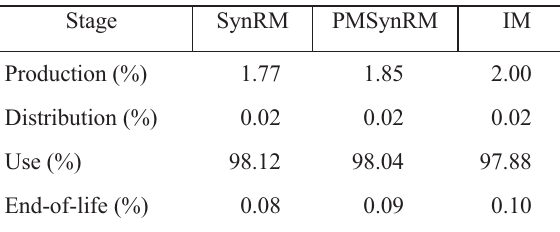
Table 5. Environmental impact made by the motors in different life cycle